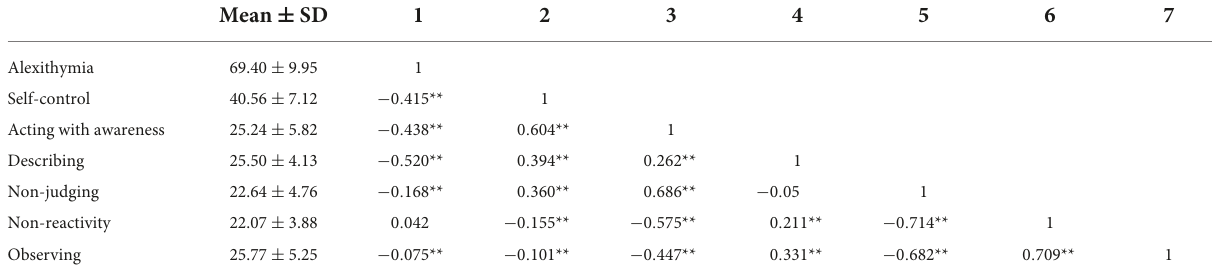
TABLE 2 The correlations of continuous